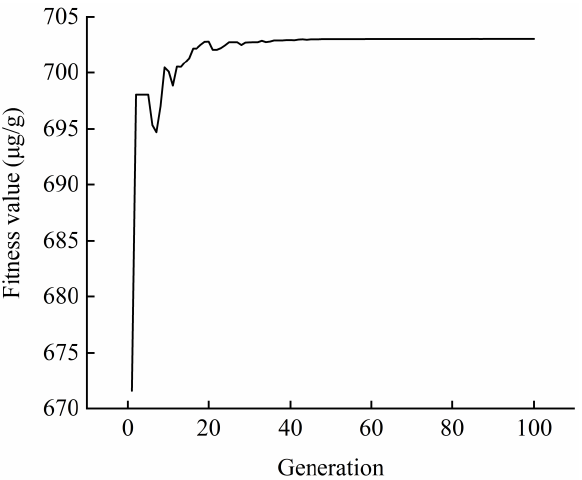
Figure 4. Fitness curve of GA-BP model.